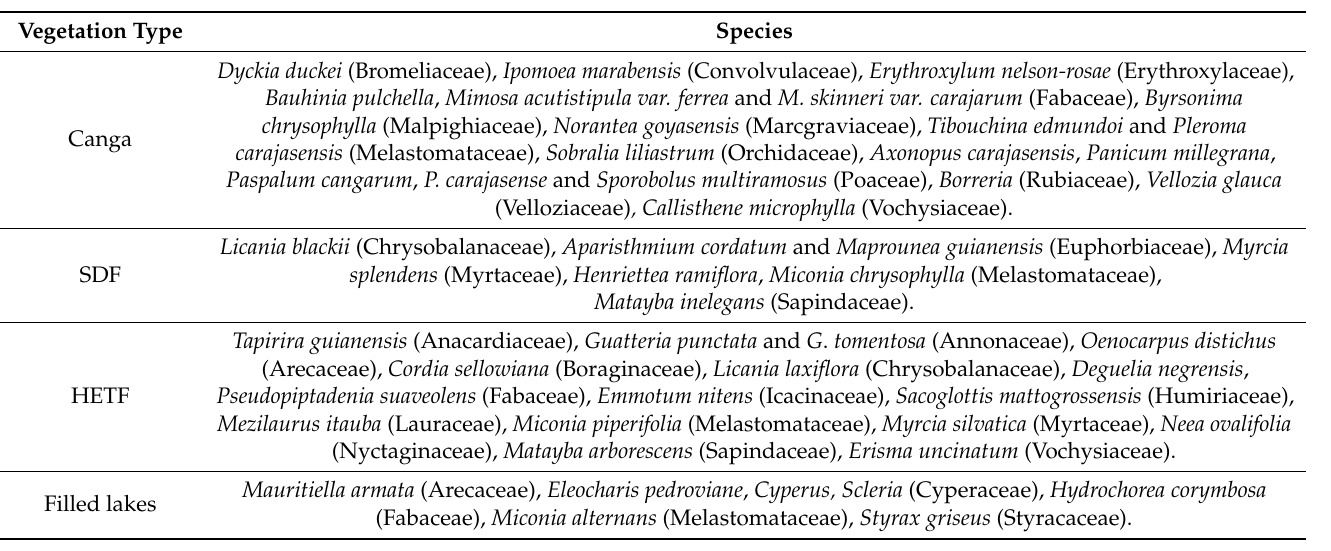
Table 1. Main plant species of canga vegetation, SDF (semideciduous tropical dry forests) HETF (hu- mid evergreen tropical forest) and filled lakes according to their based on [9,30], reviewed according to Caraj á s Flora Project